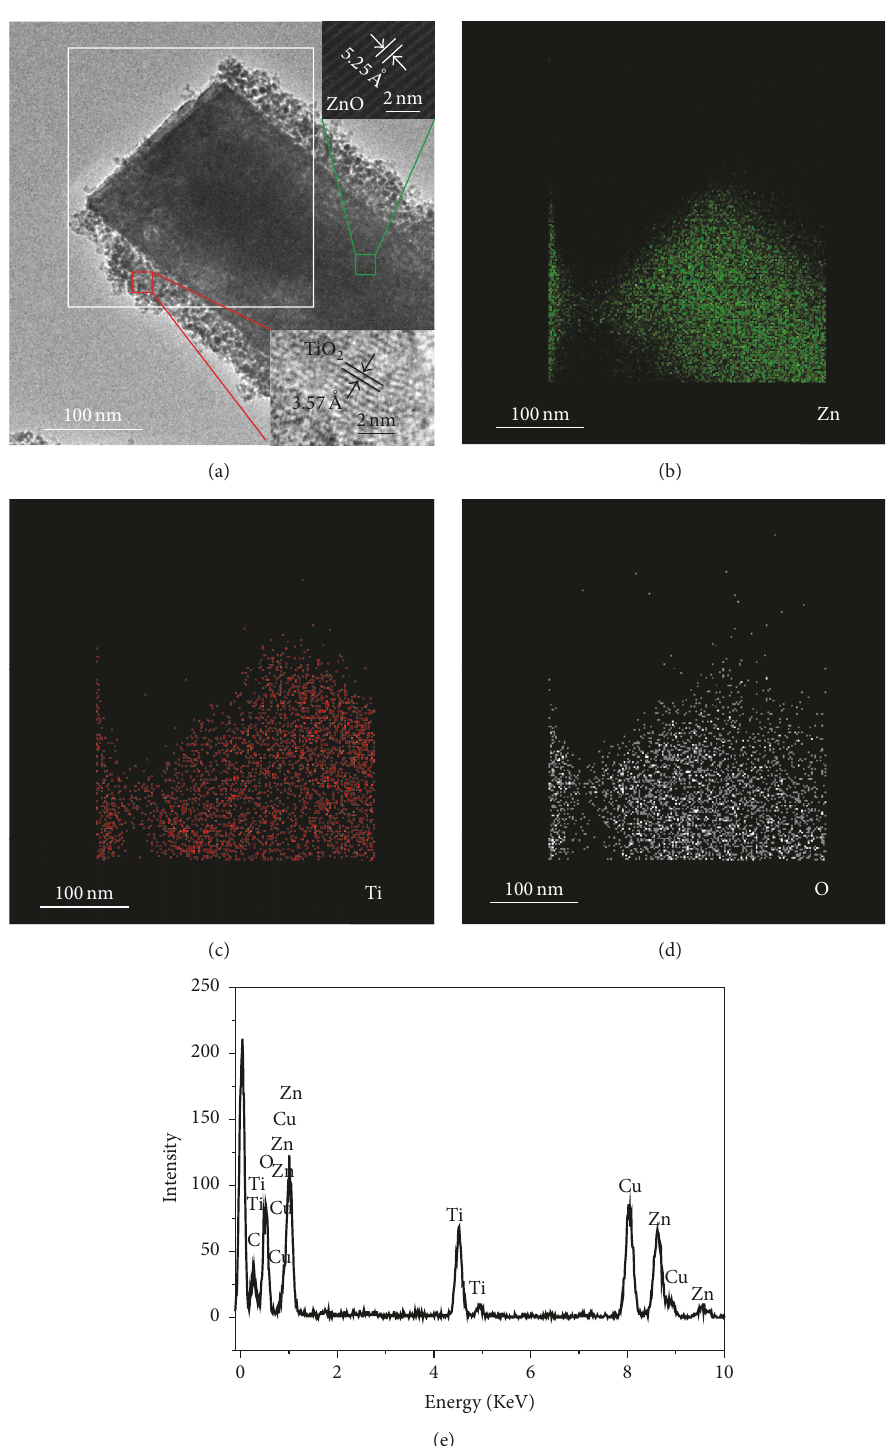
Figure 3: (a) TEM images of ZnO@TiO 2 nanorod (Inset: HRTEM image of ZnO and TiO 2 ). Electron energy loss: (b) Zn, (c) Ti, and (d) O element mapping images of the ZnO@TiO 2 nanorod. (e) EDS data of the ZnO@TiO 2